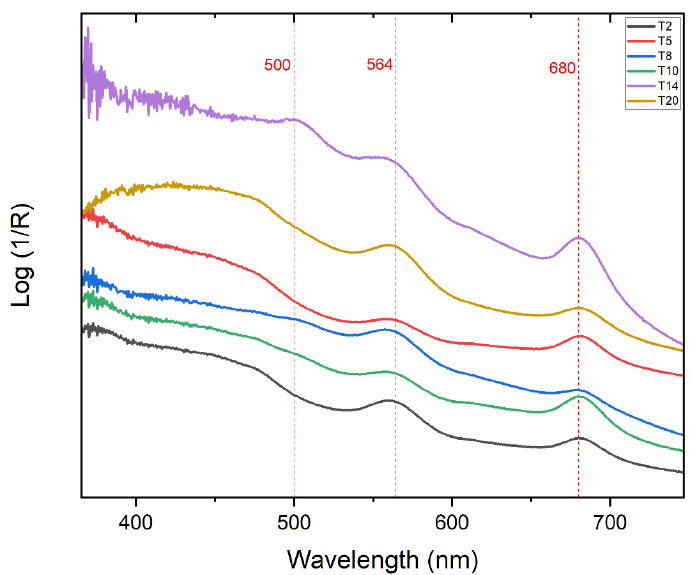
Figure 1. Absorption bands of the sample Polaroid 88 transferred on paper obtained by FORS spectrophotometer. Table 1. Absorption maxima of the mock-up Polaroid 88 transferred on paper obtained by FORS spectrophotometer. Points